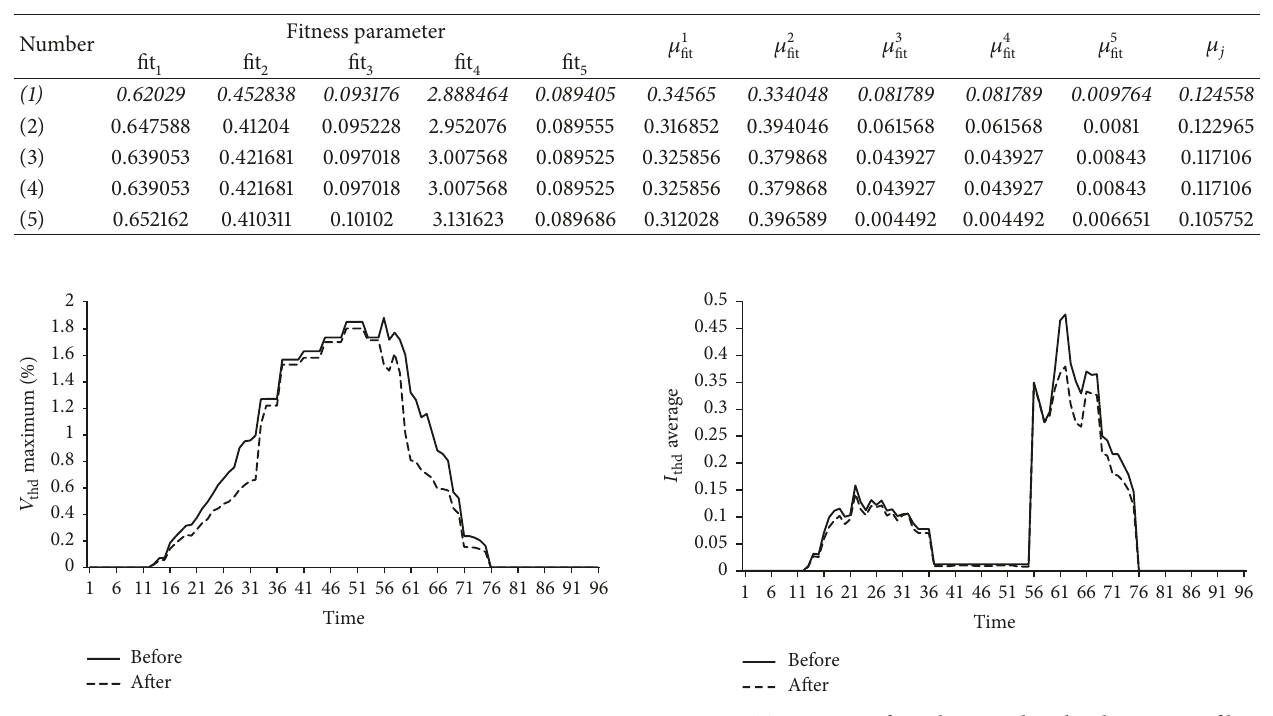
Figure 12: THD V maximum for 24 hours with and without passive filter.